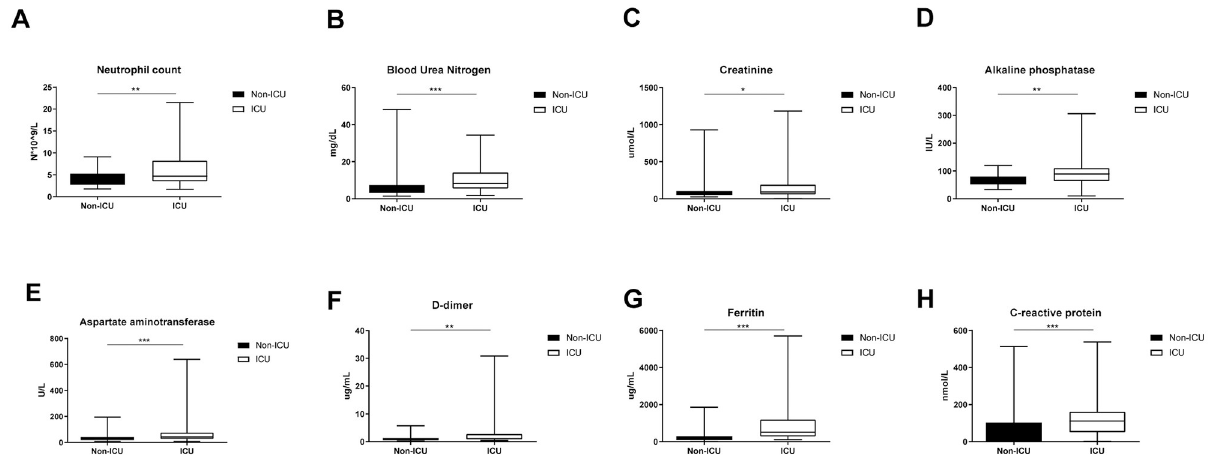
Fig 3. Boxplots for highly significant biochemical characteristics demarcating non-ICU and ICU admitted COVID-19 positive patients. Boxplot for (C) Creatinine showed a slight increase in their levels among ICU admitted group where ‘ � ’ denotes p < 0.05. Boxplot for (A) Neutrophil count, (D) Alkaline phosphatase, and (F) D-dimer showed higher amounts in ICU admitted group for respective values where ‘ �� ’ denotes p < 0.005. Boxplot for (B) Blood Urea Nitrogen, (E) Aspartate aminotransferase and (G) Ferritin and (H) C-reactive protein showed elevated levels in ICU admitted group where ‘ ��� ’ denotes p < 0.0001.